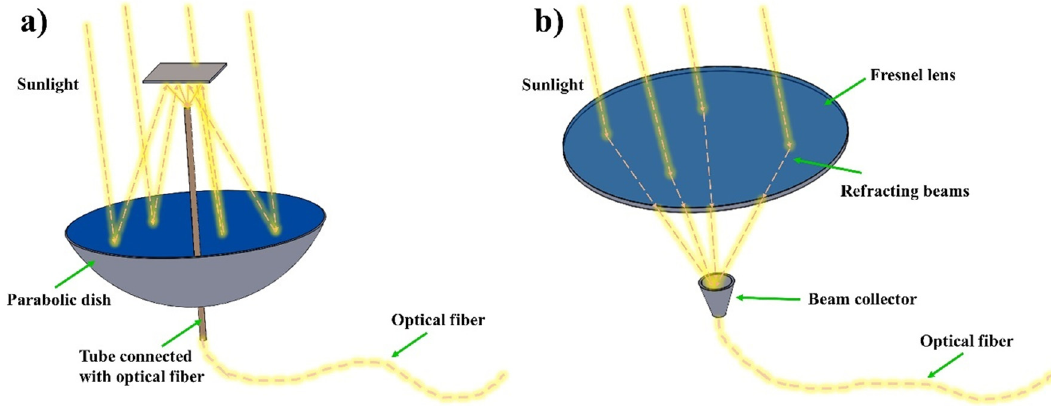
Figure 8: ( a ) The diagram shows the representation of the concentration systems formed by a parabolic disc collector that redirects the solar beams to a speci fi c central point, which redirects them to an optical fi ber with the help of a re fl ective surface. ( b ) Schematic representation of collector with the same principle with the di ff erence that a Fresnel lens is used instead of a parabolic